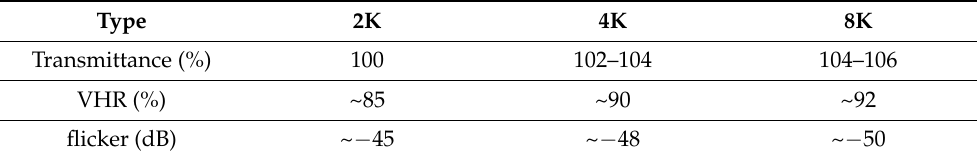
Table 1. The requirements of liquid crystal materials for 2K, 4K, and 8K display applications.